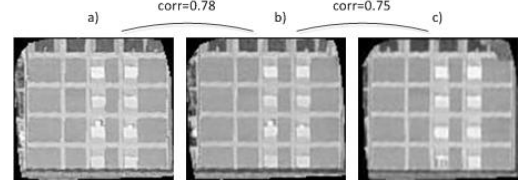
Figure 13. Same façade extracted from both epochs. a) and b) relative to pre-event and c) post event.